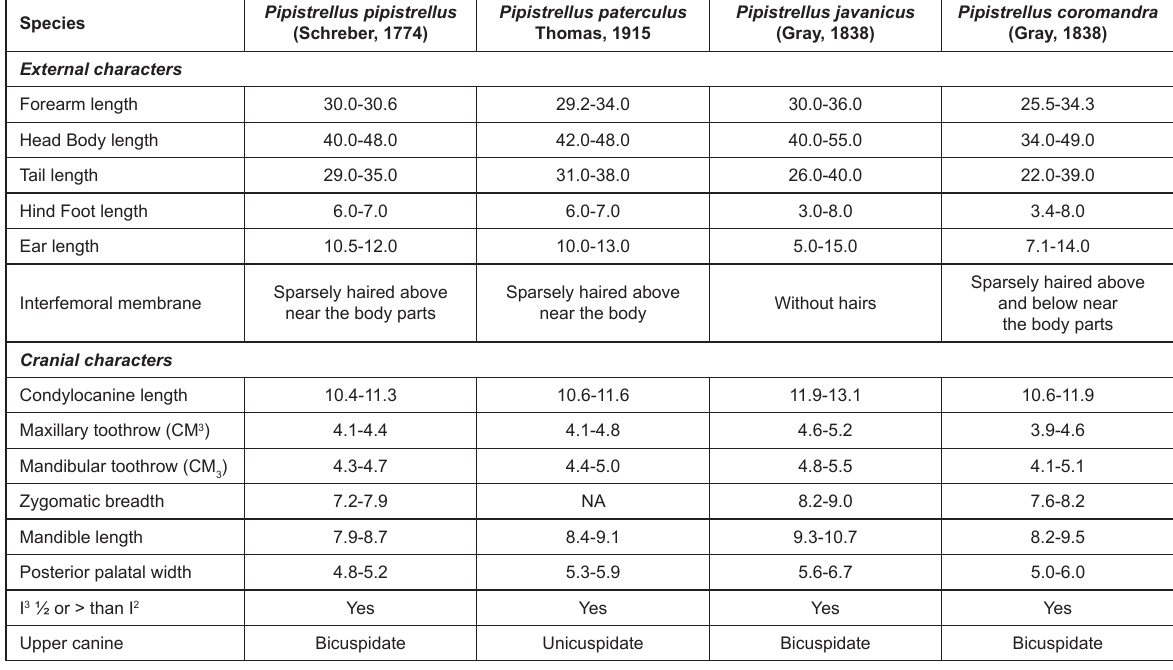
Table 7.7 (Contd..). Diagnostic morphological characters of the species belonging to the genus Pipistrellus present in South